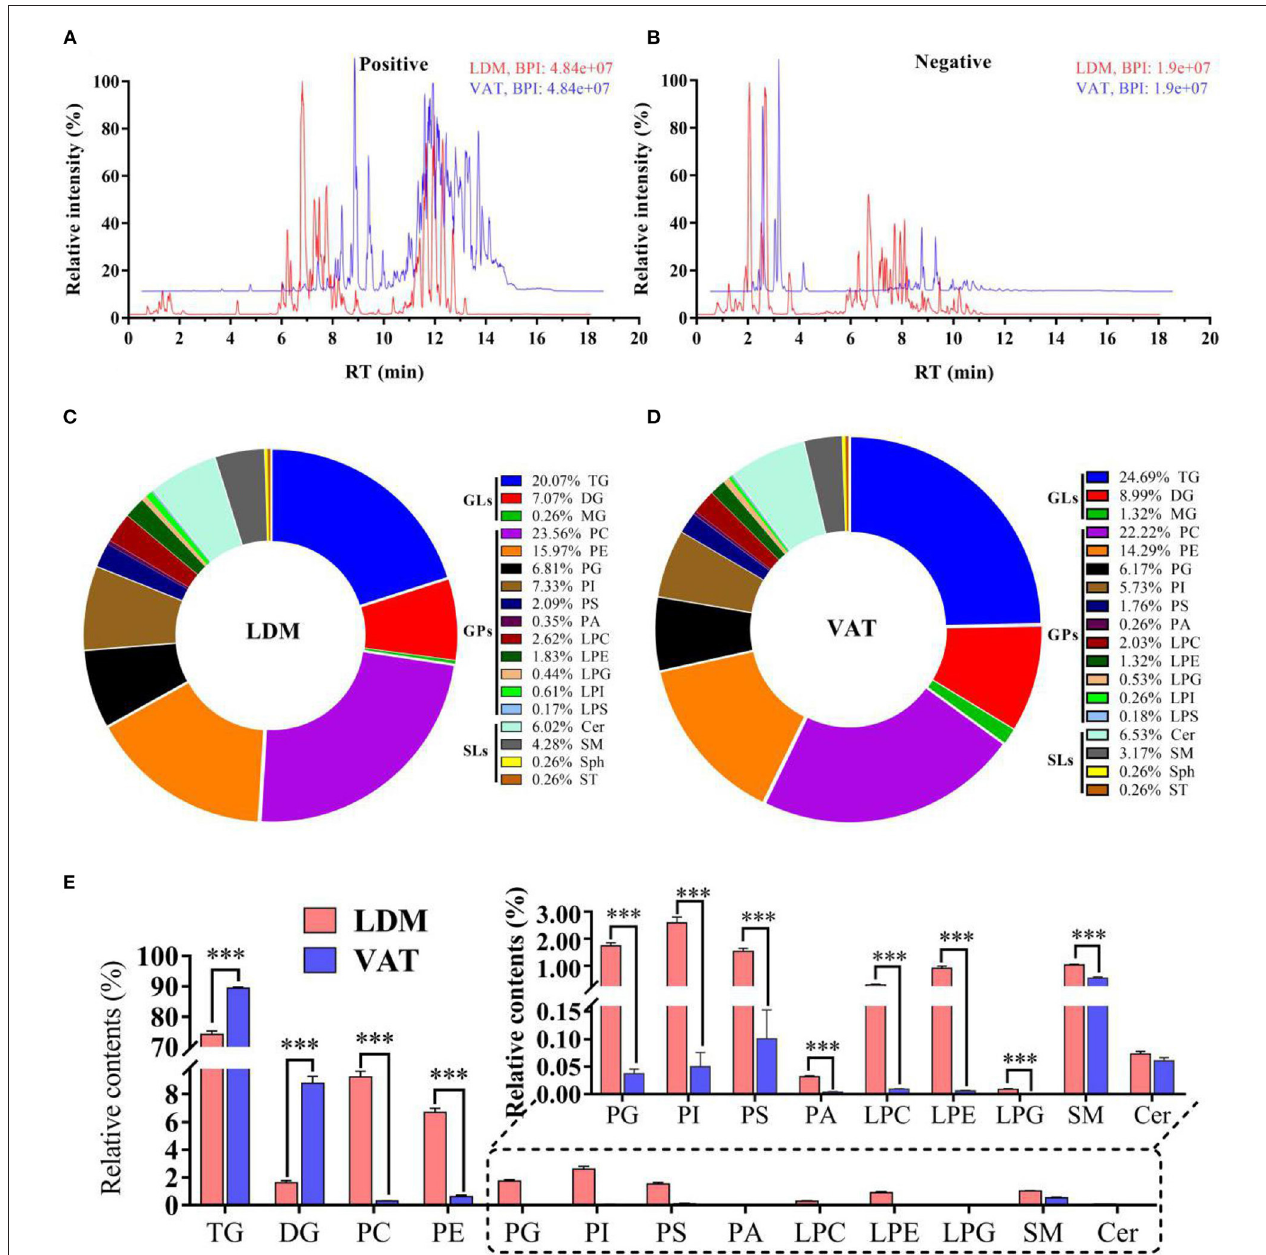
FIGURE 1 | Overall lipid composition and content in LDM and VAT of Dezhou donkey. (A,B) Representative base peak diagrams of electrospray ionization in (A) positive and (B) negative modes. (C,D) Percentage of lipid subclasses in (C) LDM and (D) VAT. (E) Relative lipid content (% total lipids) in LDM and VAT of Dezhou donkey. Values are presented as means ± SEM ( n = 9), *** p < 0.001.